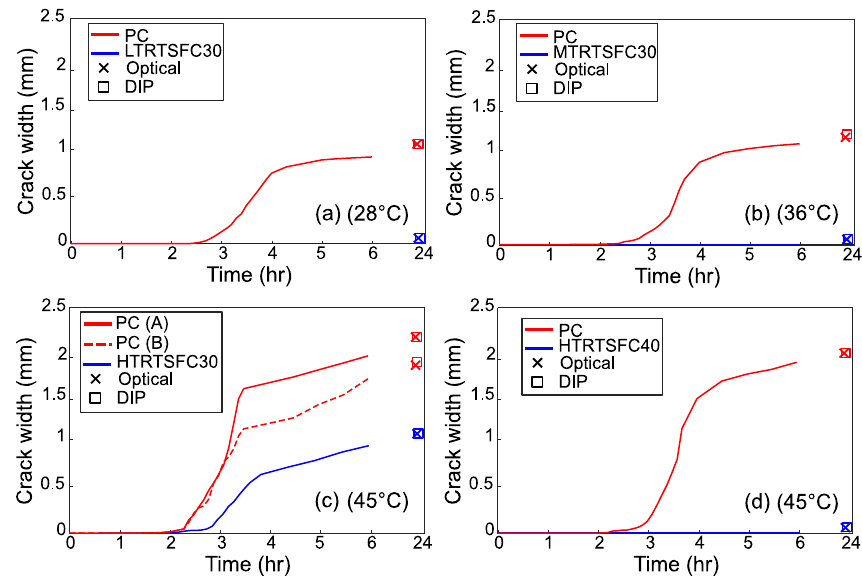
Figure 12. Crack evolution for the specimens subjected to the examined temperatures.